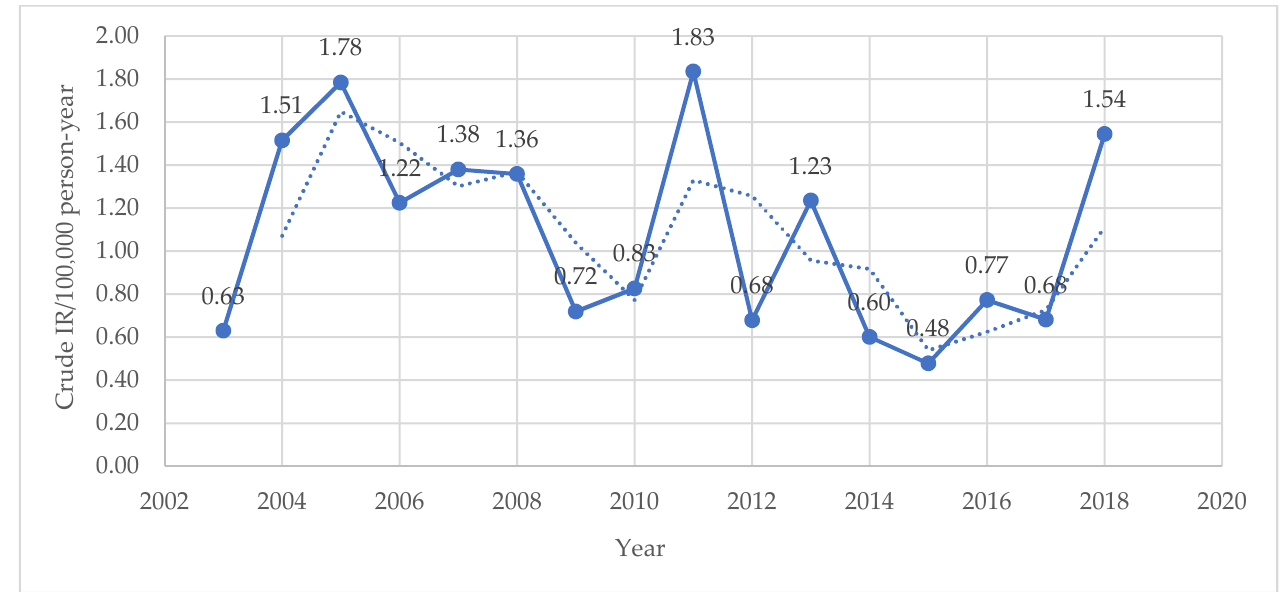
Figure 1. Trend of soft tissue sarcoma crude incidence rate over the period 2003–2018. There was a slight male predominance with 89 males and 68 females (56.7% and 43.3%, respectively) showing a male:female ratio of 1.3:1. The median age was 39 years and age ranged from less than a year to 90 years. Age distribution of cases was as follows: 32 patients (20.4%) were children and adolescents (age group: 0–19), 49 patients (31.2%) were young adults (age group: 20–39), 37 patients (23.6%) were middle-aged adults (age group: 40–59) and the remainder (39 patients; 24.8.%) were older adults aged 60 and over (Figure 2). Overall STS rates increased substantially with increasing age. For both sexes combined, the age-specific IR per 100,000 person-years ranged from 0.44 for individuals aged 0–19 years to 4.3 for those aged 60 years or older (Figure 3).